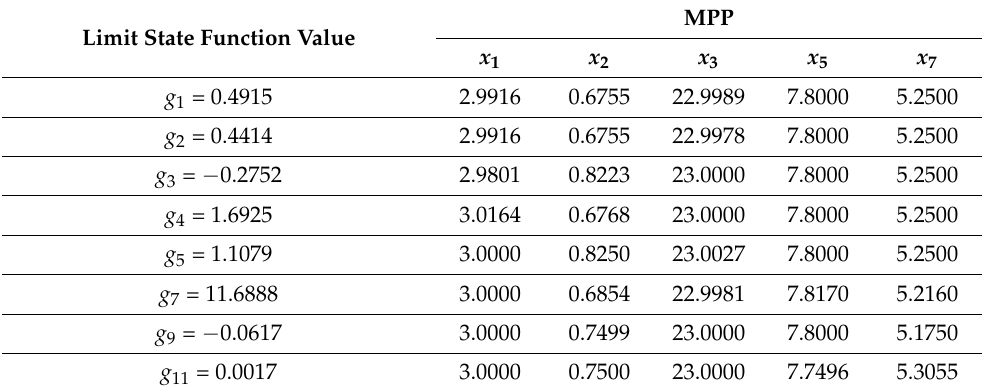
Table 3. Probabilistic reliability analysis results of limit state function with aleatory